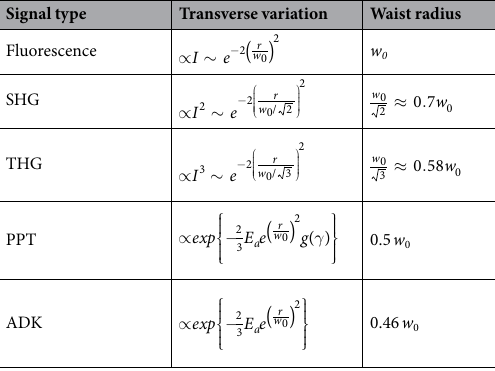
Table 1. Comparison between the spatial dependence (in the focal plane) of common imaging modalities and strong field ionization approach. The extra factor, g ( γ ), in the PPT exponential, is a function which gets the value 1 for γ = 0, and decreases monotonically with increasing γ , causing the width of the PPT curve to be somewhat wider than the ADK